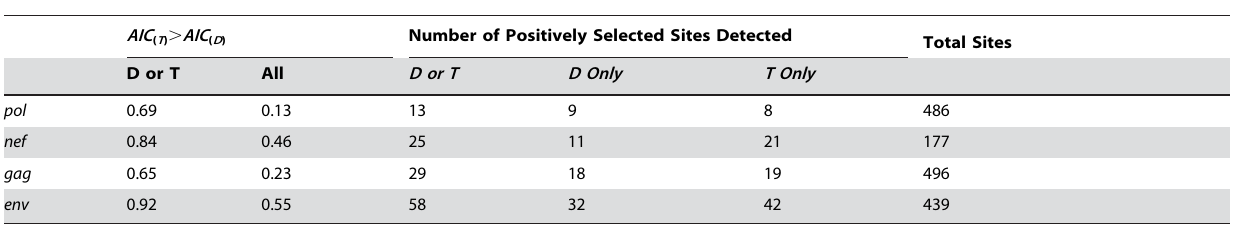
Table 3. Fit of the diversifying selection compared to the toggling model for HIV-1 sequences.